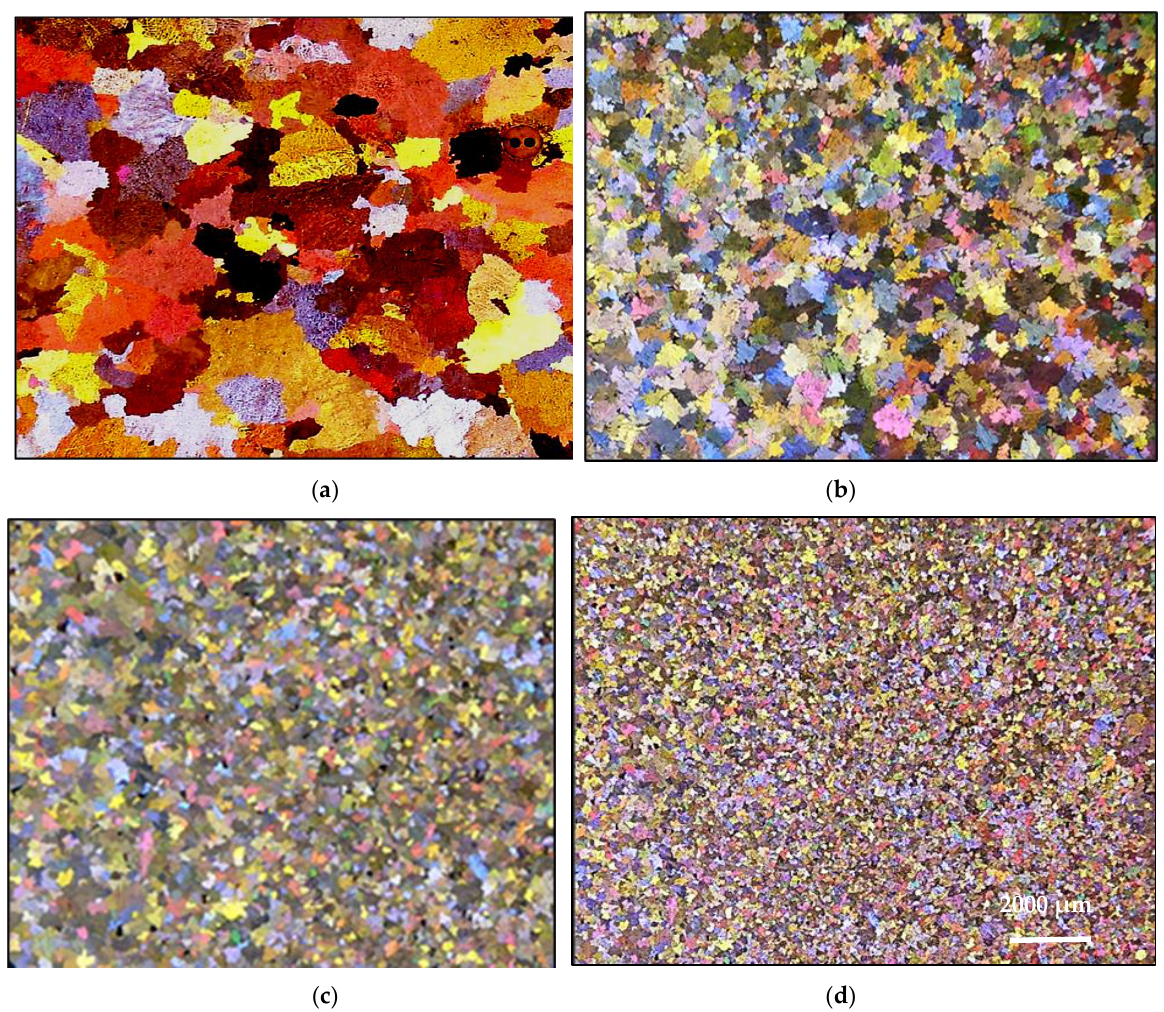
Figure 11. Effect of Ti and B addition of the A356 alloy with grain size of: ( a ) 1800 µm (0.05%Ti), ( b )